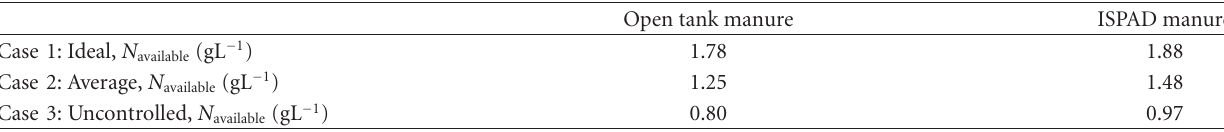
Table 4: Manure N fertilizer value for similar P and K applications for the two experimental manures, untreated (open tank) and anaerobi- cally digested